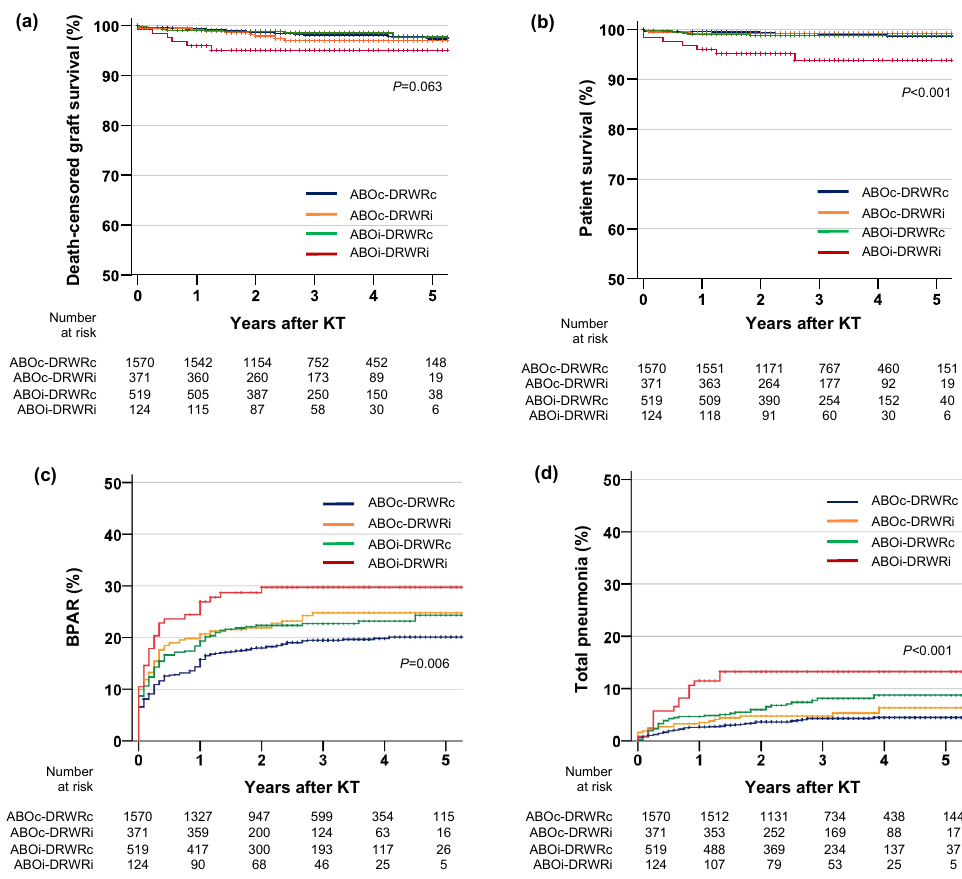
Figure 3. Kaplan–Meier analyses of the outcomes. ( a ) Death-censored graft survival, ( b ) patient survival, ( c ) BPAR, and ( d ) total pneumonia. BPAR, biopsy-proven acute rejection; KT, kidney transplantation. Table 2. Univariable and multivariable Cox analysis.